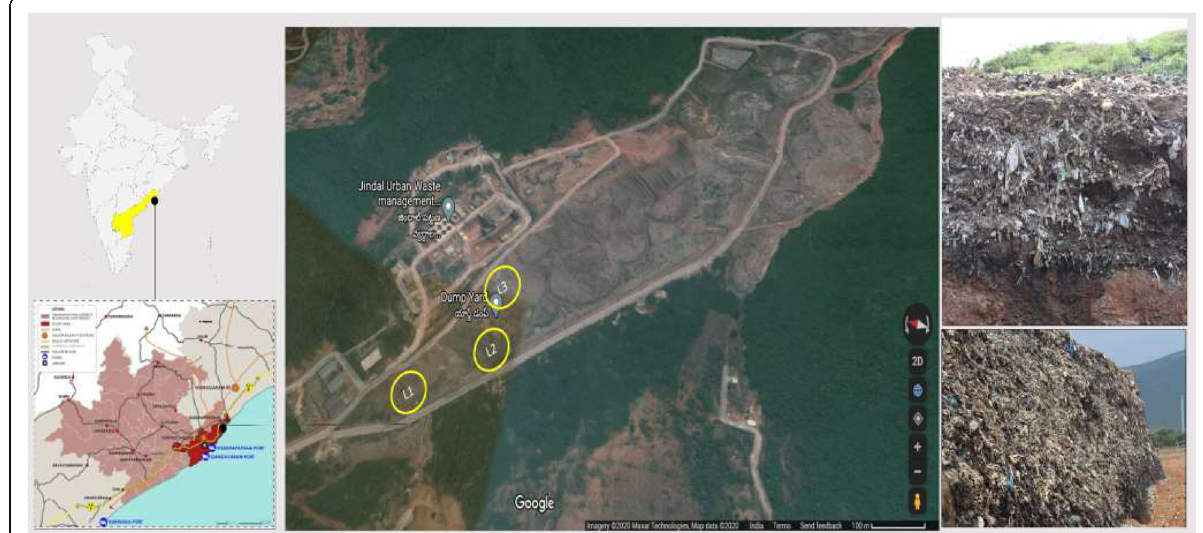
Fig. 2 Study area and sampling locations in the landfill, Visakhapatnam